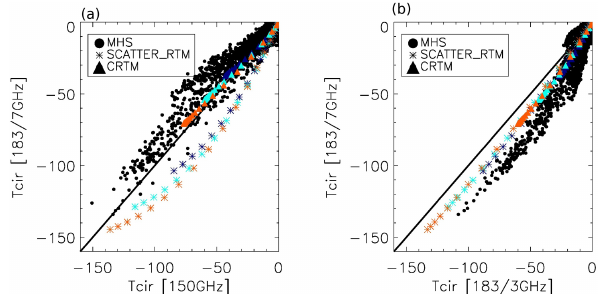
Figure C1. Scatter plots of T cir relationships between CH#2 and CH#5 (a) , and CH#4 and CH#5 (b) from observed T cir at MHS nadir view (black dots), simulated T cir from CRTM (colored trian- gles) and from CRM (colored stars). Blue/cyan/red colors represent cloud layer with tops at 10, 12 and 14km and bottoms at 7.5km in the